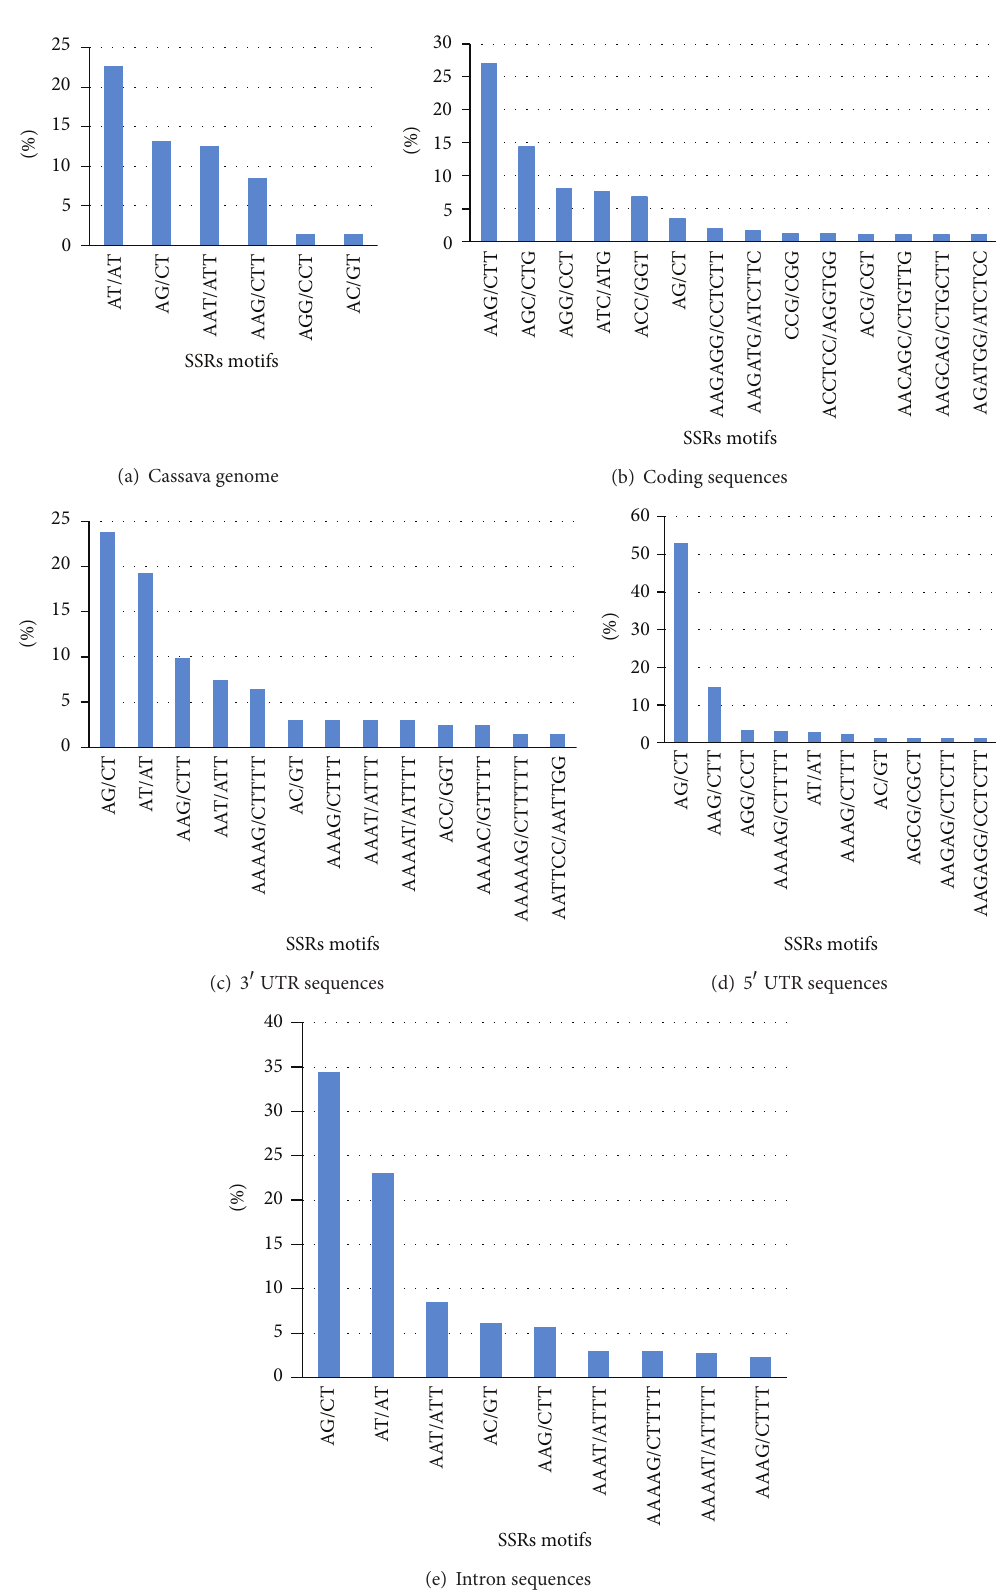
Figure 5: Frequency in percentage of the number of each SSR motif in (a) cassava genome, (b) coding sequences, (c) 3 󸀠 UTR sequences, (d) 5 󸀠 UTR sequences, and (e)